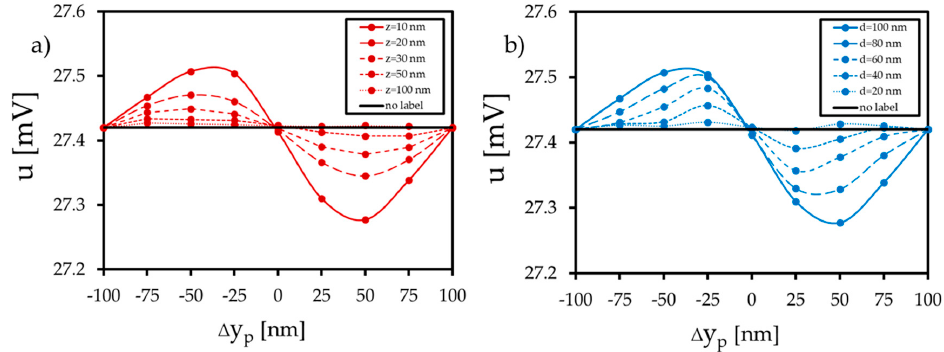
Figure 9. Simulated electric potential u of the GMR element due to the y-shift in the magnetized label. ( a ) Electric potential due to di ff erent label heights ∆ z (d = 100 nm). ( b ) Electric potential due to di ff erent label diameters d ( ∆ z = 10 nm).